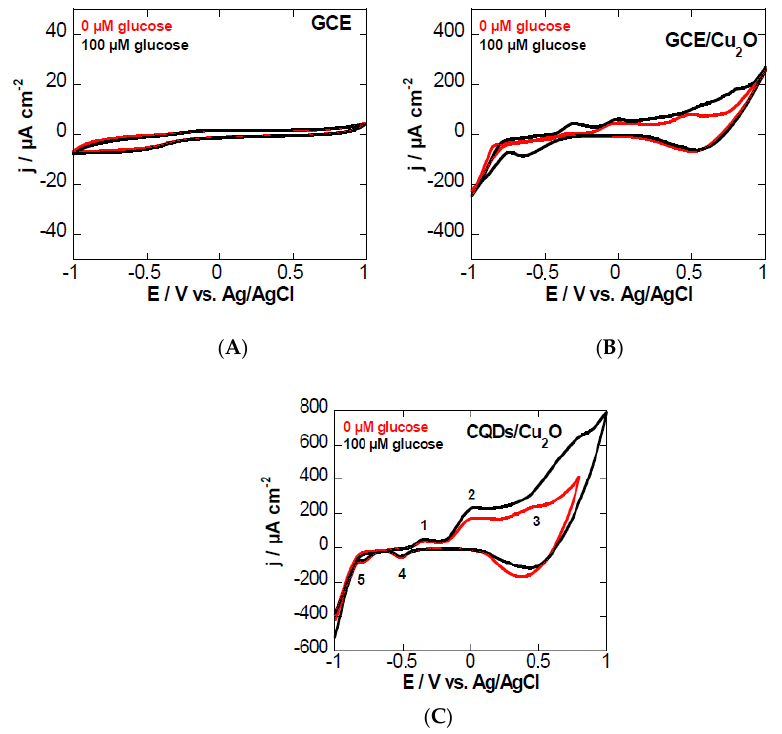
Figure 3. Cyclic voltammograms of ( A ) glassy carbon electrode (GCE); ( B ) GCE/Cu 2 O; and ( C ) GCE modified with CQDs/Cu 2 O by drop casting in 0.1 M NaOH aqueous solution in the absence (red) and presence of glucose (black, 100 µM).